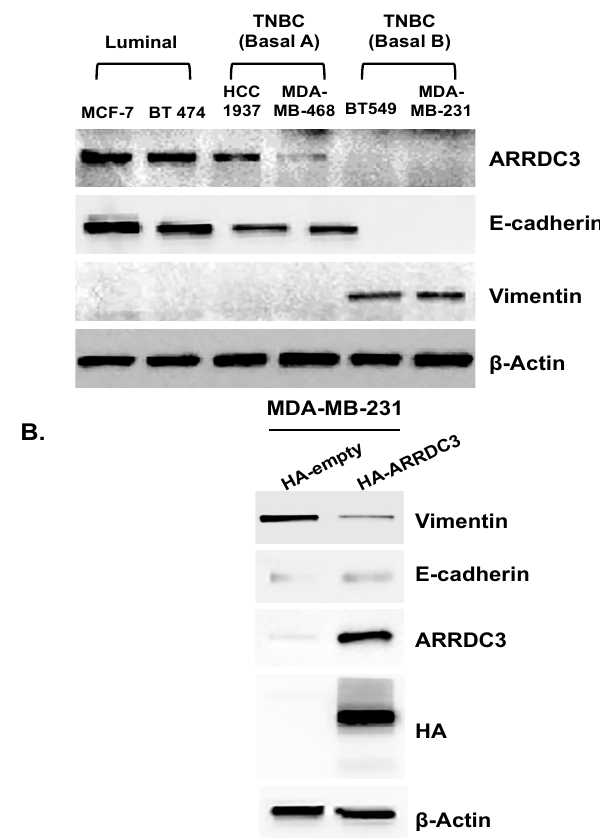
Figure 2. ARRDC3 reverses EMT phenotypes in mesenchymal subtype of TNBC cells. ( A ) Whole